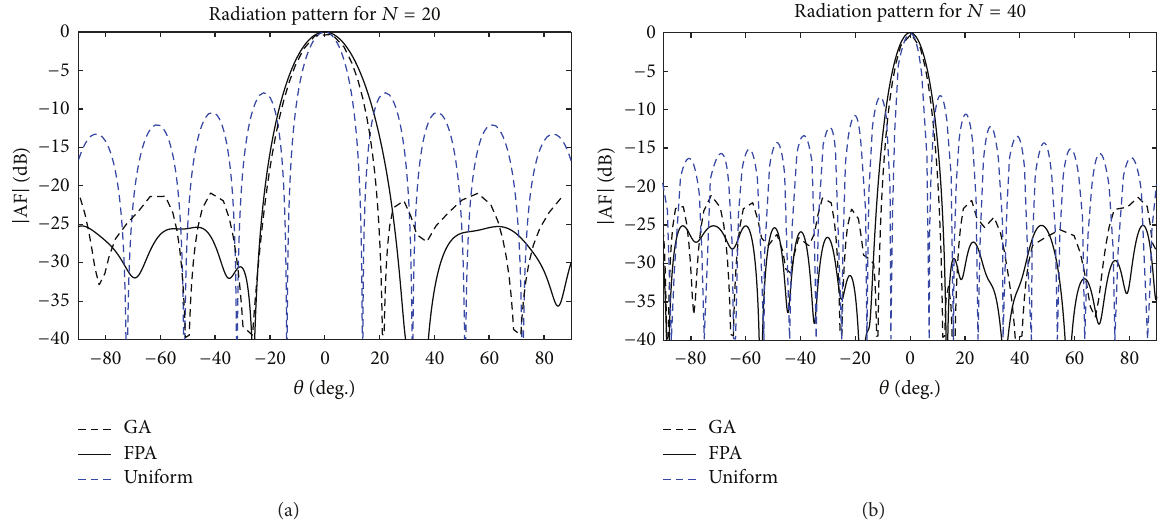
Figure 3: Comparison of the radiation patterns of CAA using weights obtained by FPA and uniform distribution for (a) 𝑁 = 20 and (b) 𝑁 = 40 .